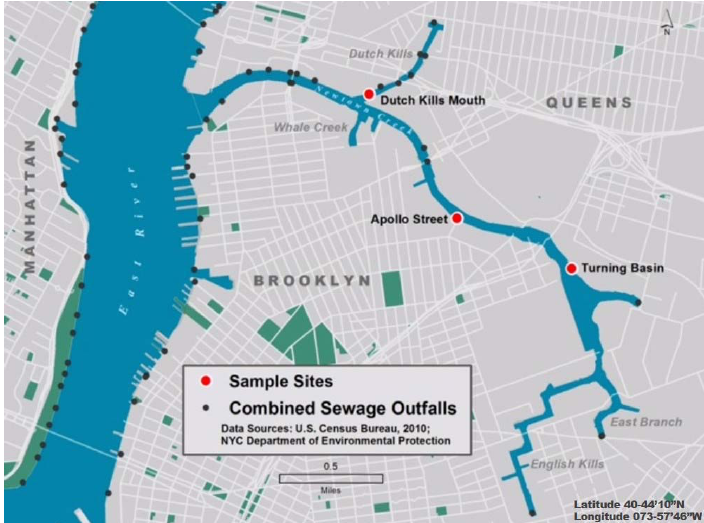
Fig. 1: Map of water sampling locations along Newtown Creek, New York, USA